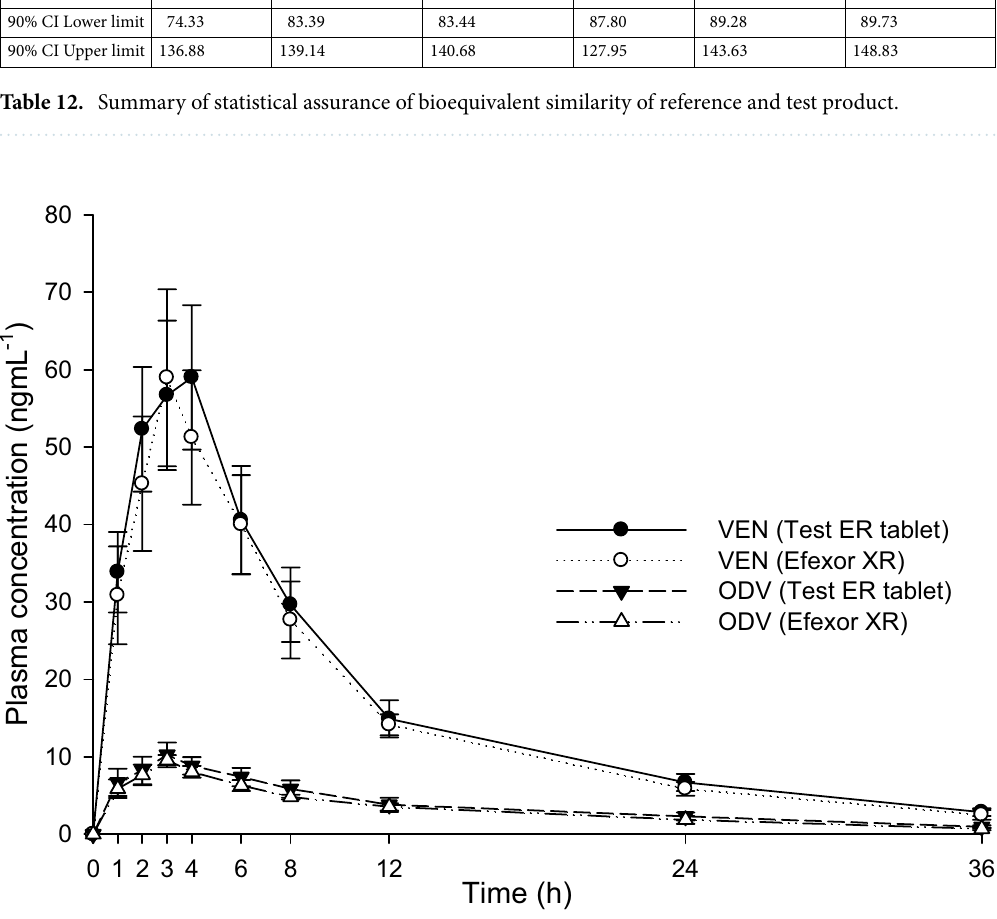
Figure 11. Mean plasma concentration versus time plots after a single oral dose of test ER tablet and Efexor XR 37.5 mg in New Zealand white